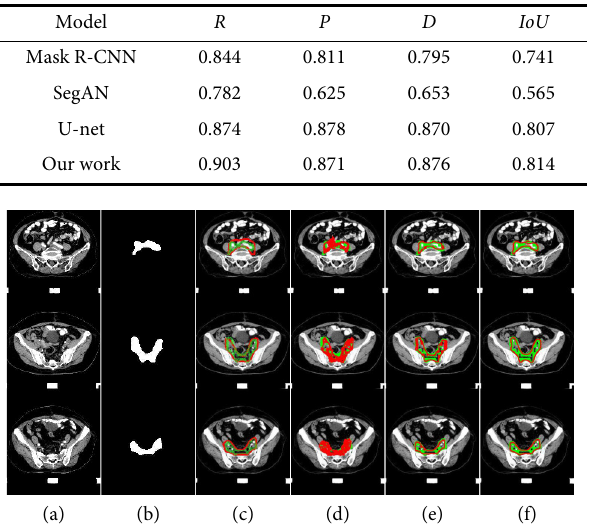
Fig. 3 Segmentation results. Column (a) shows three CT images; Column (b) shows the ground truth of the CTV targets in CT images; Columns (c), (d), (e), and (f) show the results given by Mask R-CNN, SegAN, U-net, and our model,